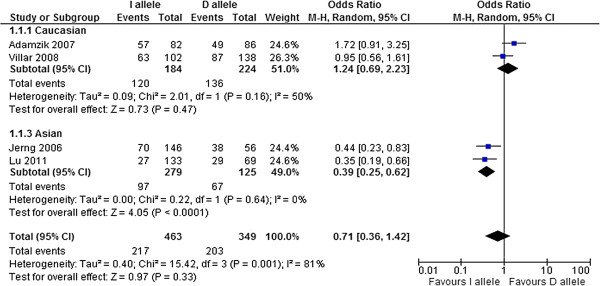
Forest plot of OR with 95% CI forACEI/D polymorphism in ALI/ARDS mortality: allele model.